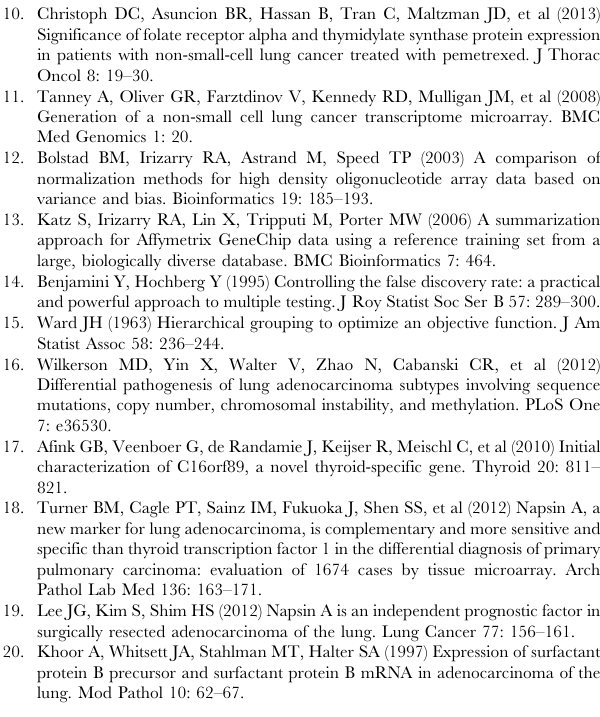
Figure S1 Study design. CR, complete response; IV, intravenous infusion; N, maximum number of patients planned; NSCLC, non-small cell lung cancer; PR, partial response; SD, stable disease; Vit = vitamin. Figure S2 Quality assessment of gene expression pro- filing samples. Array data were assessed using the EQC program, which utilizes a distribution based analysis using.rpt files with appropriate thresholds and confidence limits iteratively derived from inspection of resultant distributions. Samples failing this initial EQC assessment underwent rehybridization and re- assessment. For samples passing the initial EQC or re-assessment, the array images were subjected to AIA to identify any major artifacts affecting the data. Finally, the data were subjected to batch analysis and data integrity checks, which were performed using n-way analysis of variance and PCA respectively. Abbrevi- ations: AIA, array image analysis; EQC, Almac Extended QC; RNA, ribonucleic acid; PCA, Principal Components Analysis. Figure S3 Number of significant associations (unadjust- ed p-value , 0.01) identified between the RMA expres- sion of individual genes on the Lung Cancer-DSA microarray and PFS and OS (N =51 patients; Cox regression analyses including RMA gene expression either as continuous or as dichotomous variable). Dichotomous analysis: The respective median value of the gene is used as cut-point). Both analyses combined: Significant association in both continuous and dichotomous analysis.